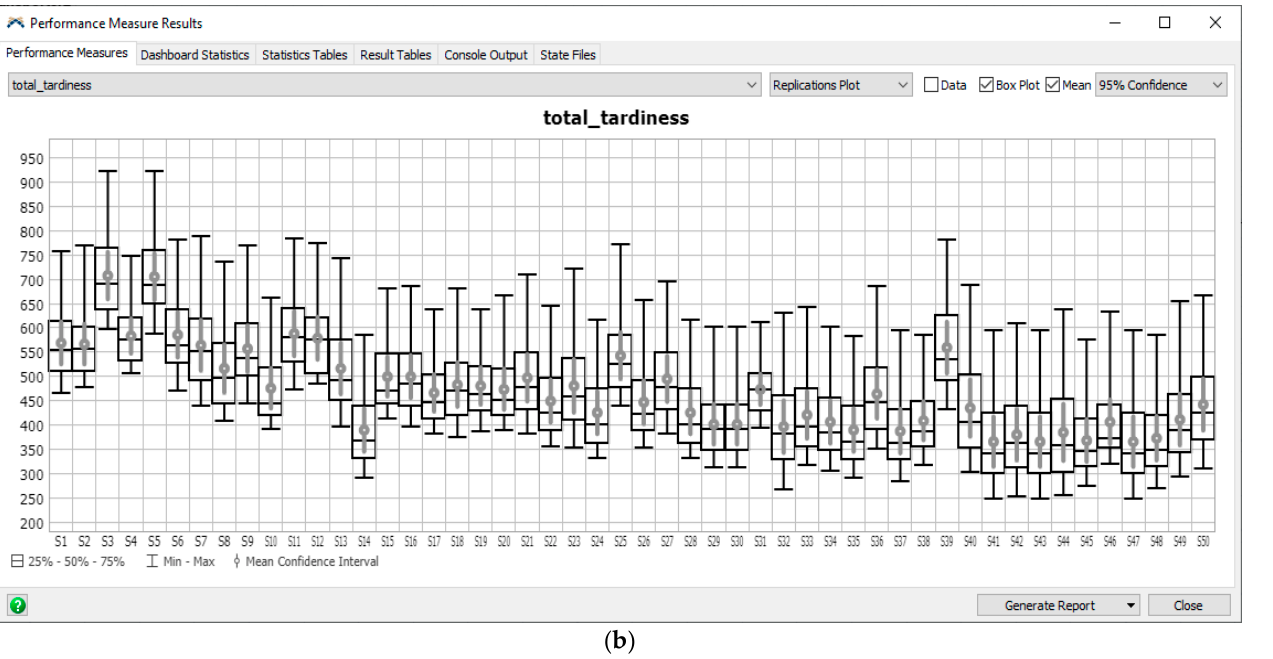
Figure 11. Cmax ( a ) and TT ( b ) of schedules (schedules S1–S50) obtained using the IA and verified in FlexSim.